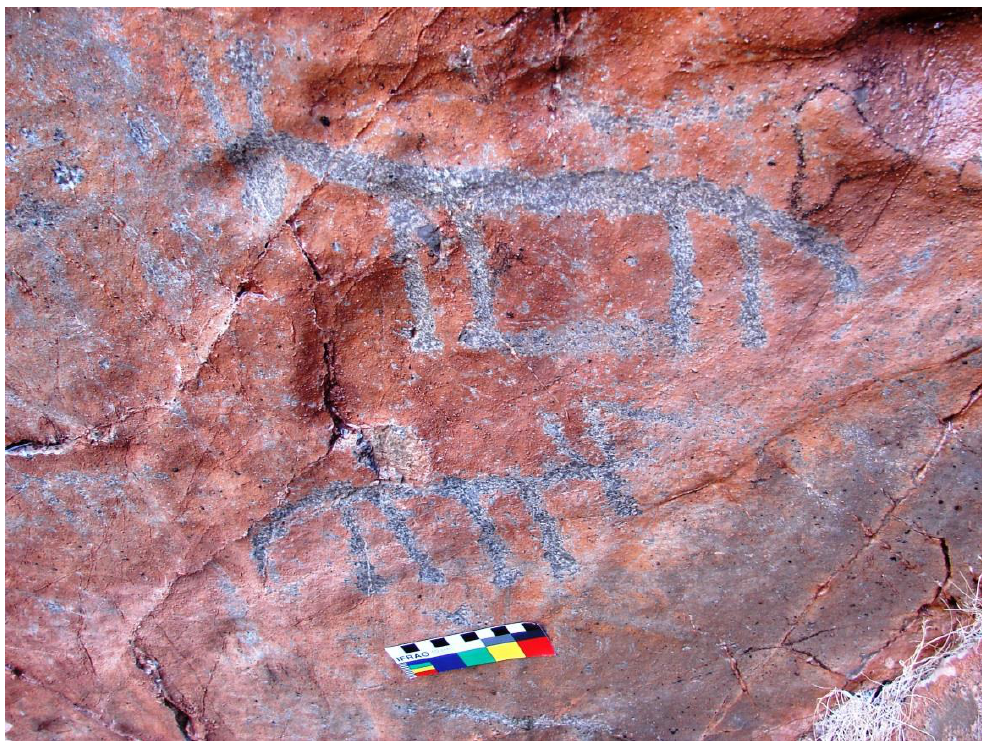
Figure 4. Depiction of zoomorphs with short “horns”.